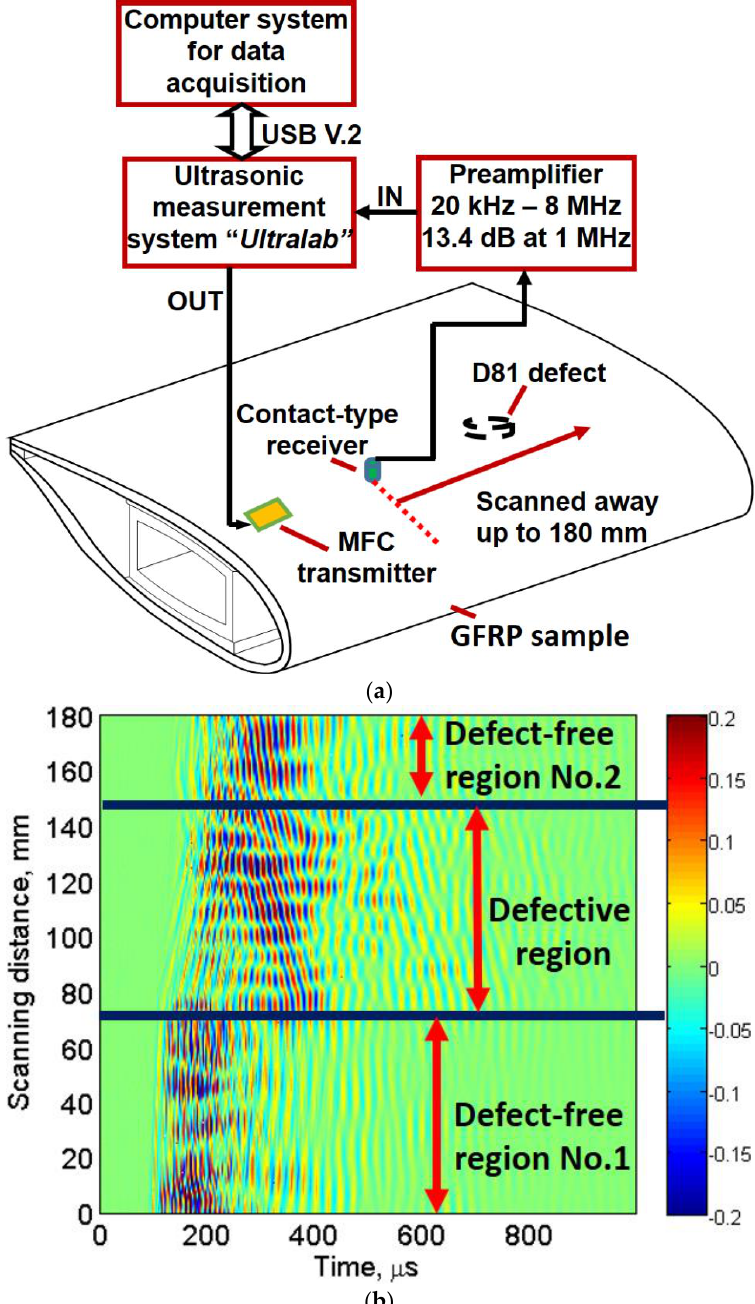
Figure 2. GW testing: ( a ) schematic of experimental investigation of the sample; and ( b ) acquired B-scan image from the linear scanning.